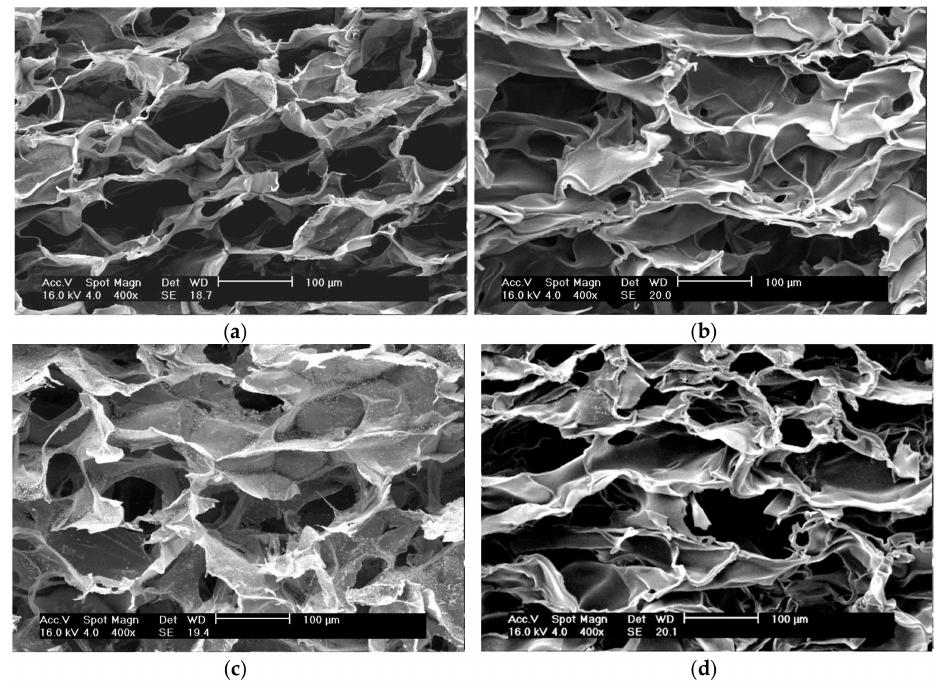
Figure 3. SEM images of ( a ) sericin-chitosan sca ff old with chitosan MW of 15,000 g / mol with 1:1 ratio, ( b ) chitosan sca ff old with a MW of 15,000 g / mol, ( c ) sericin-chitosan sca ff old with chitosan MW of 100,000 g / mol at a ratio of 1:1, and ( d ) chitosan sca ff old with a MW of 100,000 g / mol (at X400